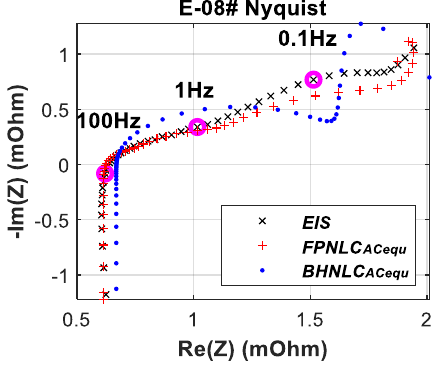
Figure 18. Nonlinear circuits fitting for EIS: ( a ) FPNLC ACequ ; ( b ) BHNLC ACequ .